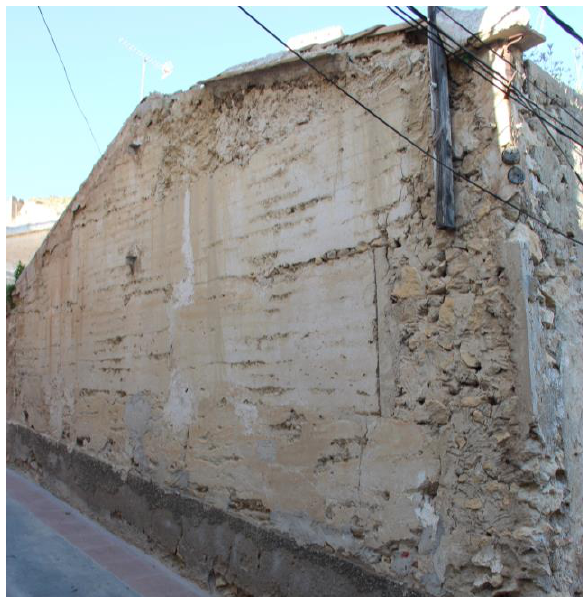
Figure 9. Gypsum-crusted rammed earth wall and gypsum guided masonry pillars (Source: authors).